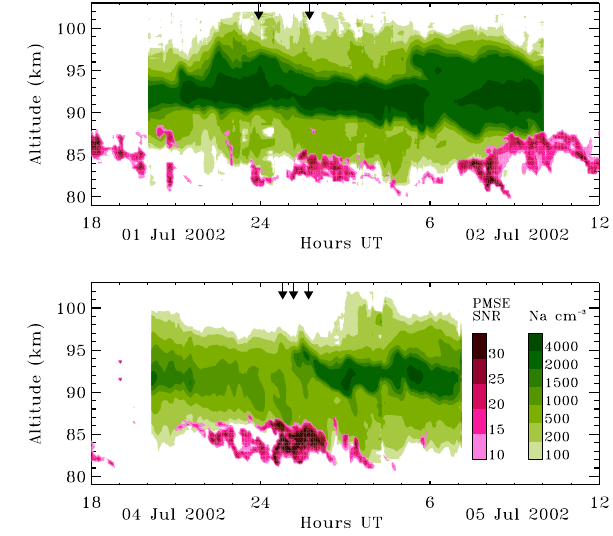
Fig. 10. The upper and lower panels show composite time-height contours of Na (green shading) and PMSE intensity during the two summer salvo periods. The MaCWAVE/MIDAS flight times are designated by arrows at the top of each panel. The Na and PMSE time-contours exhibit similar small-scale variability induced by gravity wave effects. Note the distinct cutoff between the bottom of the Na layer and the top of the PMSE layer in each